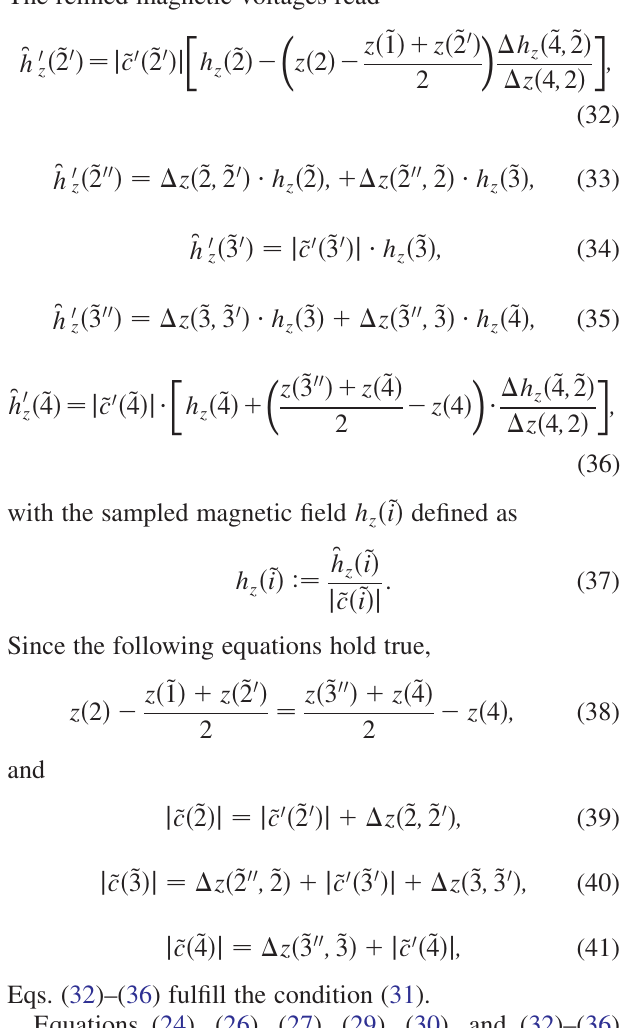
ð ~ 2 Þ , ̑ h ð ~ 3 Þ , and z z ~2 ~4 and